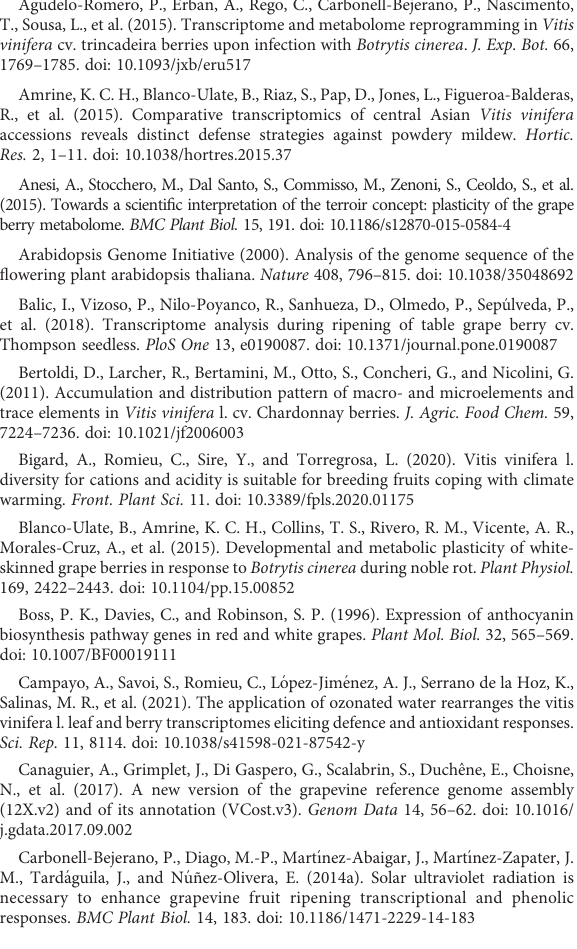
SUPPLEMENTARY TABLE 1 Listof (A) transcriptomics, (B) metabolomics, (C) proteomics,and (D) ionomics studies retrieved from the literature. Data was collected from NCBI using different queries and keywords. Only the studies published until 12/2021 were considered. Data were manually curated to remove clear